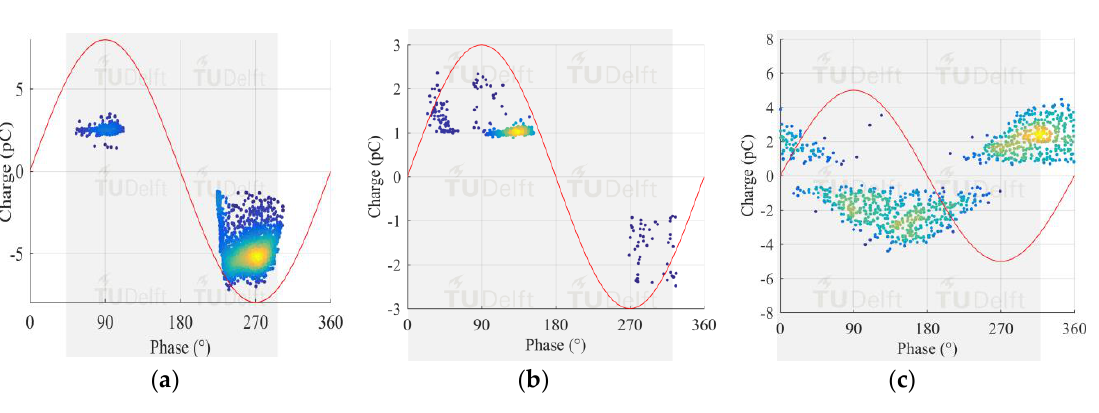
Figure 8. ( a ) Corona discharge; ( b ) Surface discharge; ( c ) Free moving particle.